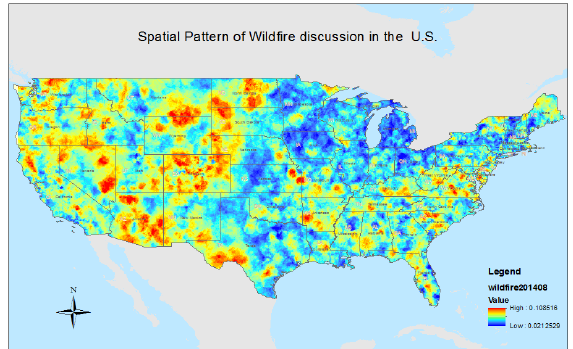
Figure 4. Wildfire potential estimated from Wikipedia 2014